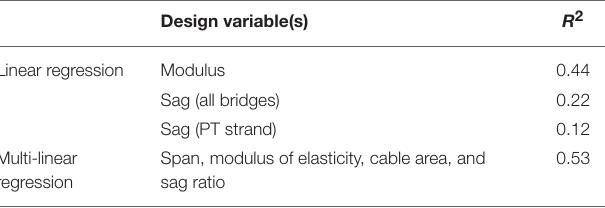
TABLE 5 | Design variables and corresponding R 2 in empirical formula of